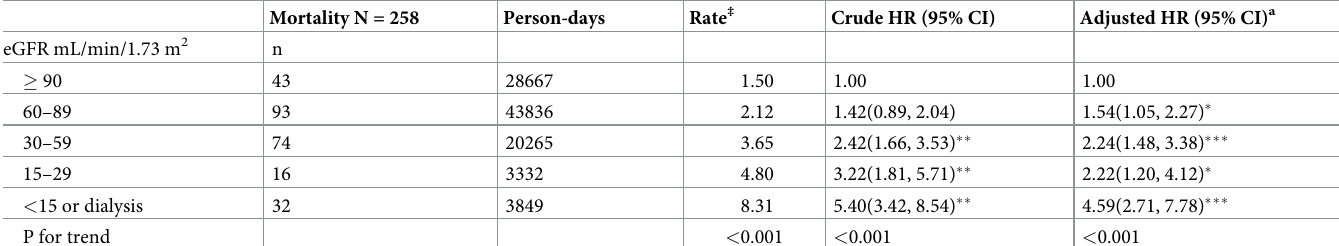
Table 2. Incidence and hazard ratios of mortality at 1 month after intracerebral hemorrhage by eGFR levels on admission. Mortality N =